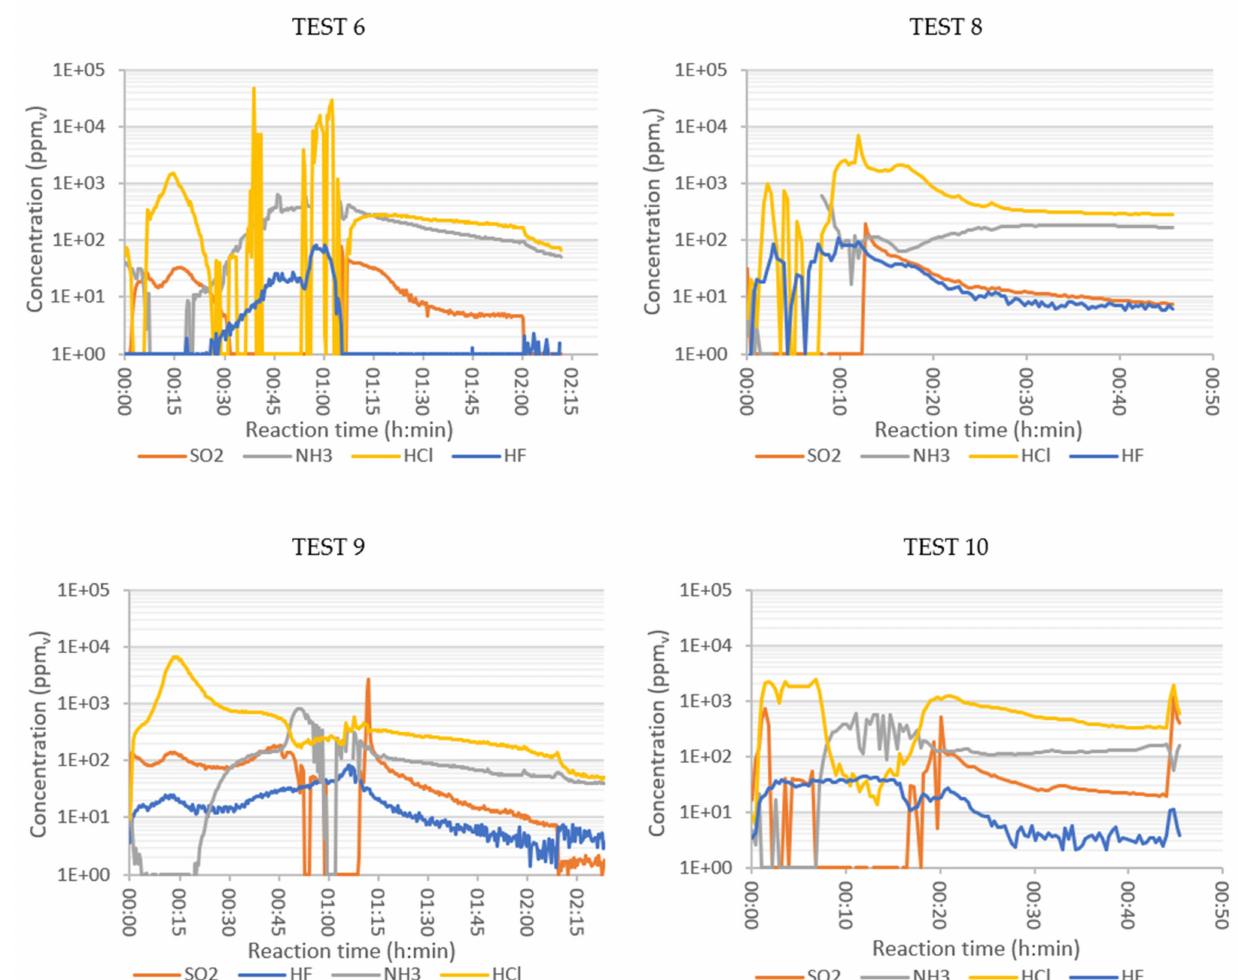
Figure 4. Concentration of SO 2 , NH 3 , HCl, and HF (ppm in volume) in the flue gases of combustion of SRF: Test 6 (air, 550 ◦ C), Test 8 (oxygen, 900 ◦ C), Test 9 (air, 900 ◦ C), and Test 10 (enriched air, 900 ◦